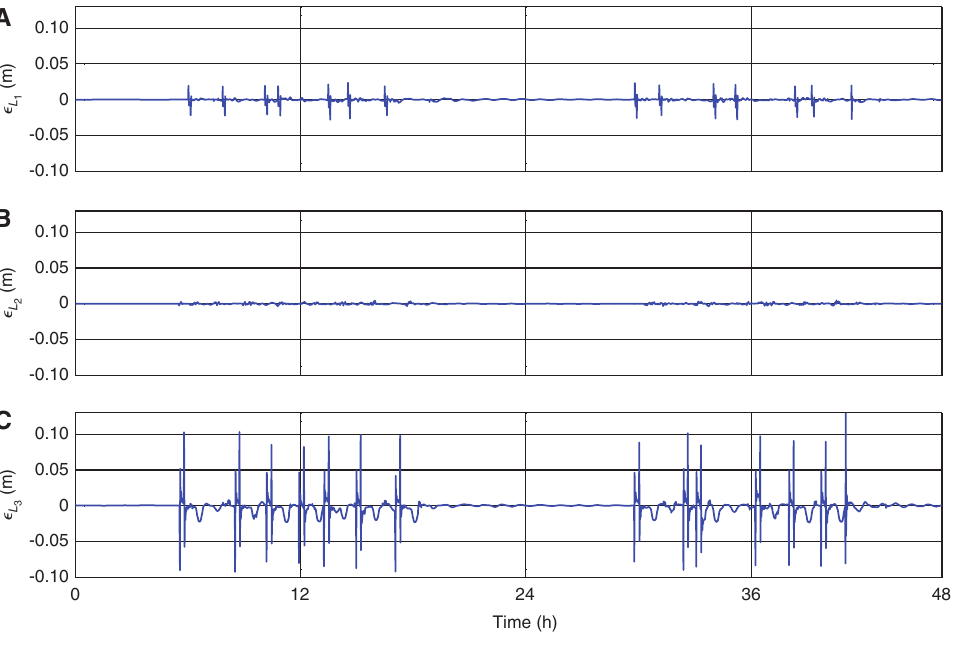
( ) k (cid:31) – Cuinchy, (B) L 1